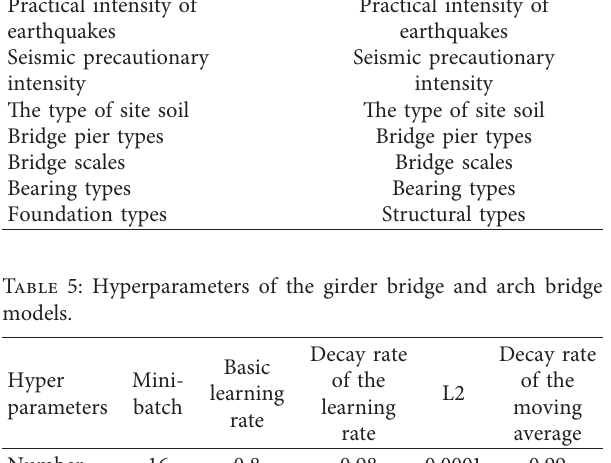
Figure 2: Processing of the girder bridge and arch bridge in random forest models: (a) girder bridge; (b) arch bridge. Table 4: Selected features of the girder bridge and arch bridge. Girder bridge